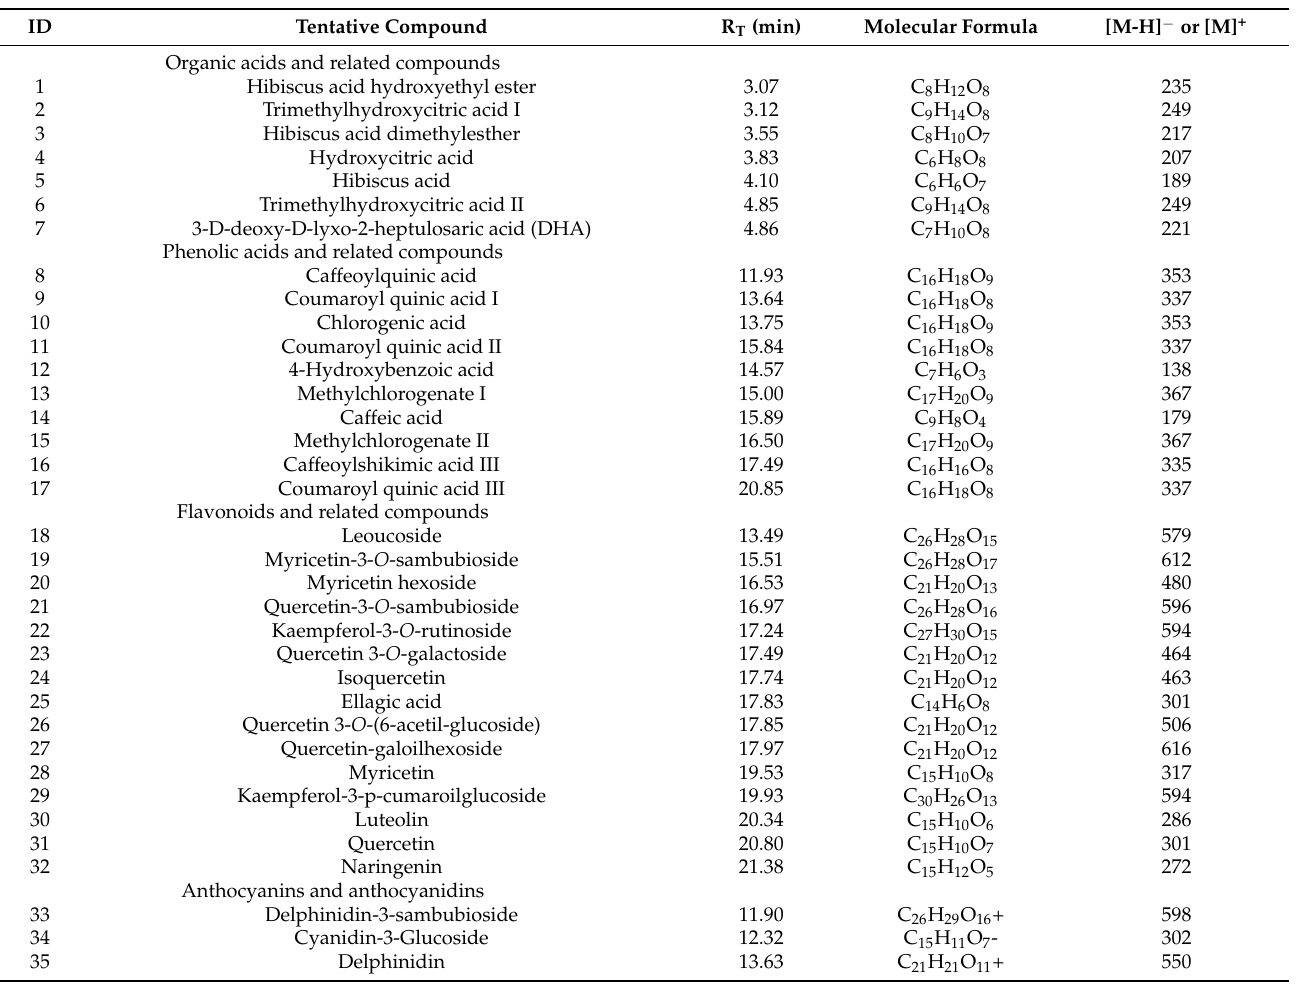
Table 1. Phenolic compounds and organic acids identified by HPLC-DAD-ESI-MS in commercially and Hibiscus beverages at the initial stage and released during in vitro intestinal